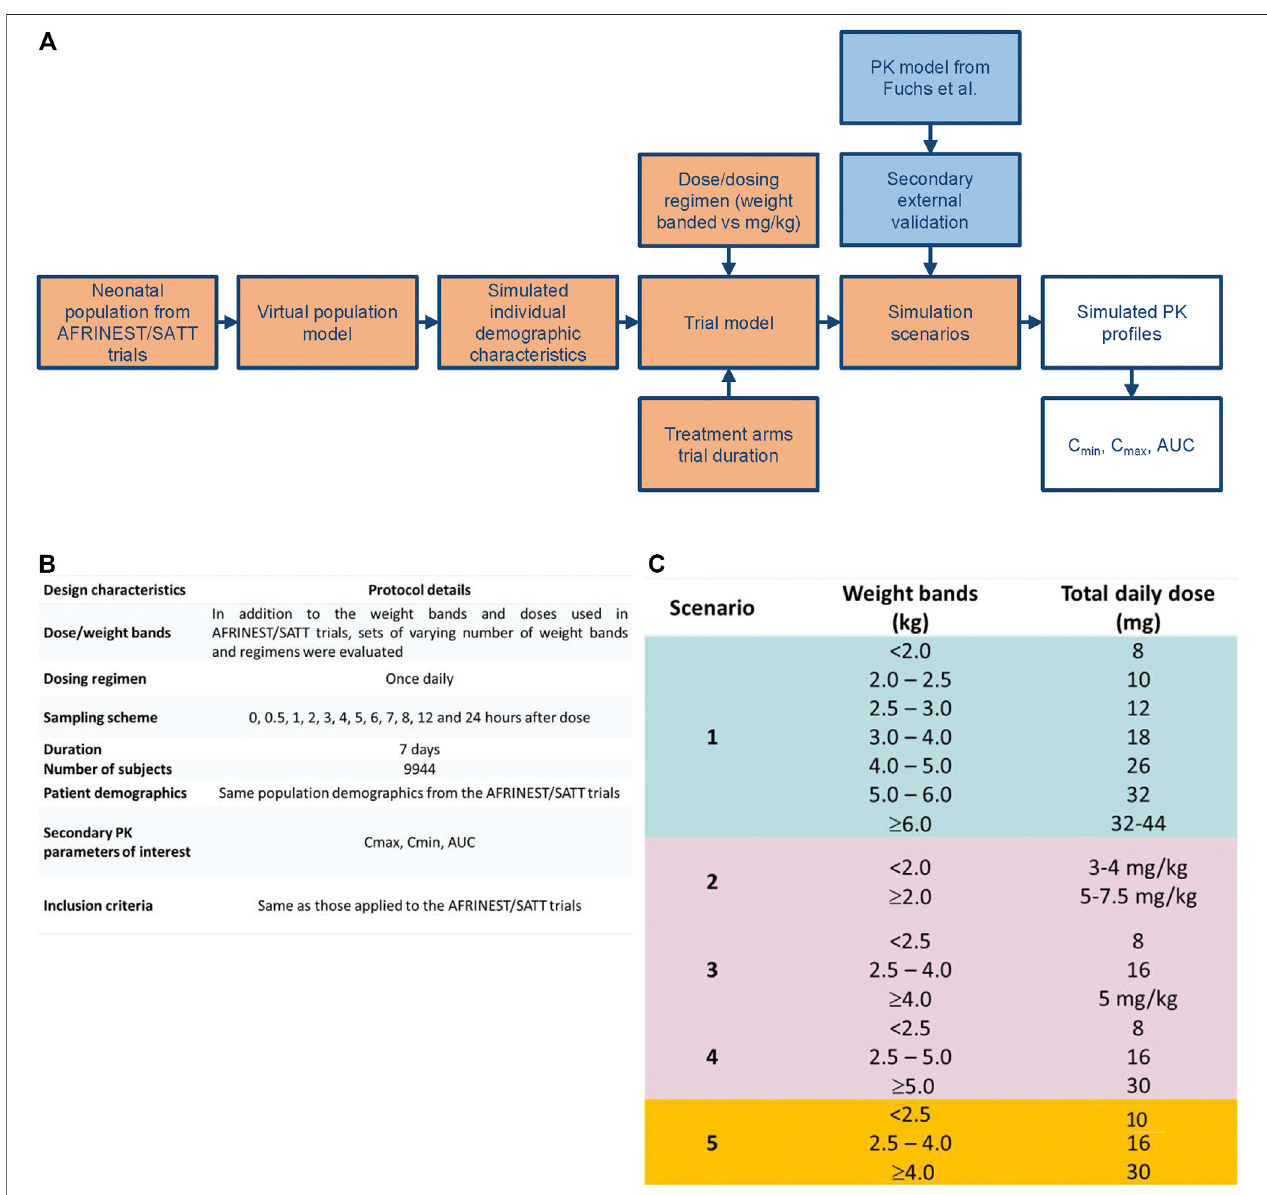
FIGURE 2 | (A) Work fl ow for the implementation of clinical trial simulations aimed at the evaluation of simpli fi ed dosing regimens for gentamicin in neonatal sepsis. (B) Designcharacteristicsforthestudyprotocolusedintheclinicaltrialsimulations. (C) Simulationscenariosevaluatedfortheidenti fi cationofasimpli fi eddosingregimen based on weight bands and fi xed